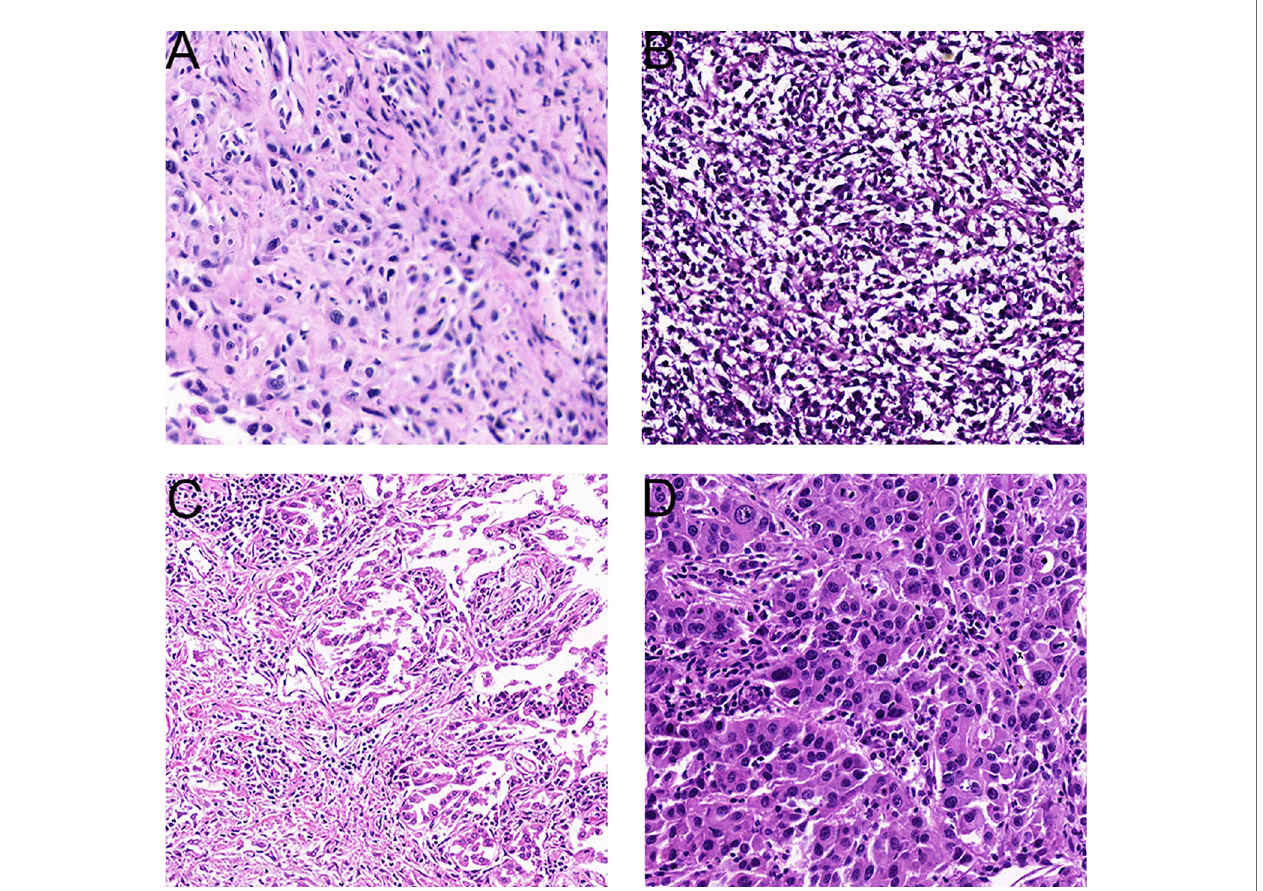
FIGURE 1 | Representative tissue histology of PSC tumors. (A) , Spindle cell carcinoma (HE× 200). (B) , Carcinosarcoma (HE×200). (C) , Pleomorphic carcinoma (HE×200). (D) , Giant cell carcinoma